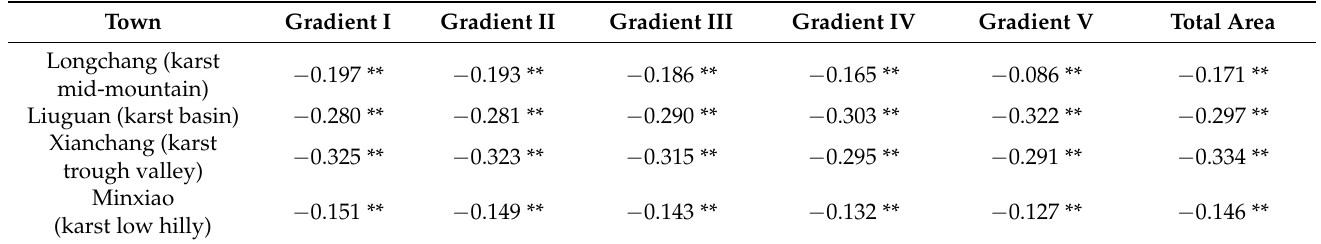
Table 7. The correlation coefficient (global Moran's index) between the non-agriculturalization of cultivated land and landscape ecological risk.